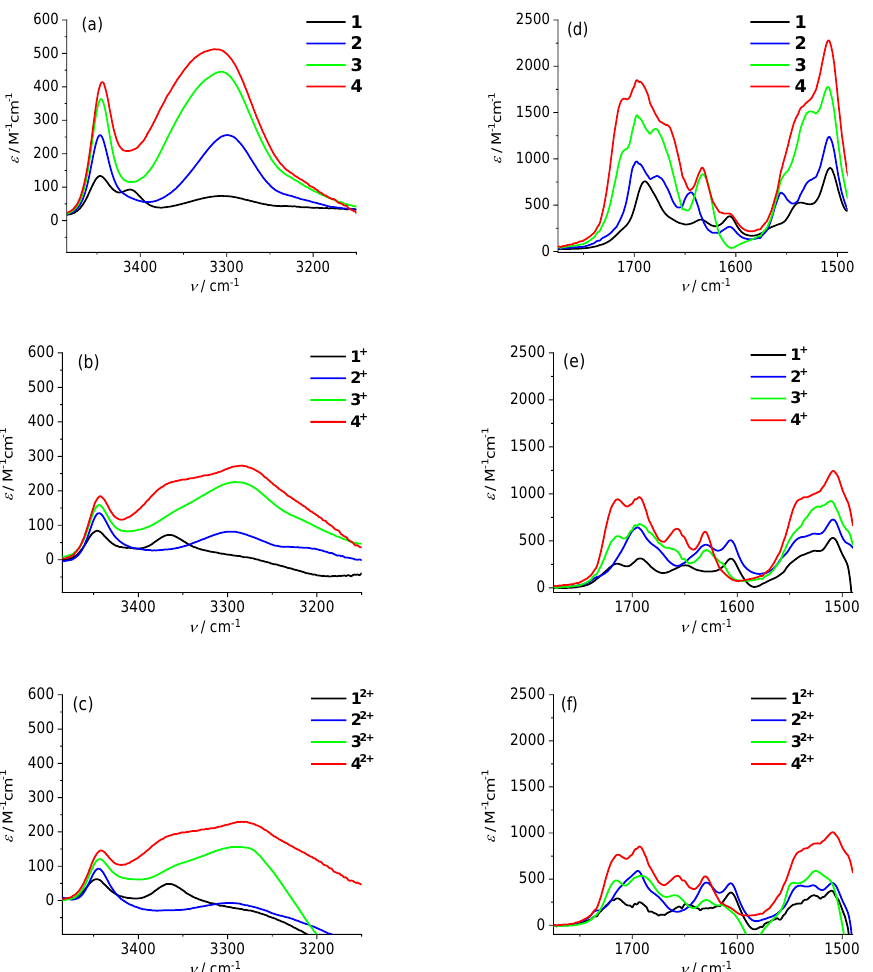
Figure 10. IR absorption spectra ( left : amide A region, right : carbonyl region) in CH 2 Cl 2 /0.1 M n Bu 4 NPF 6 of ( a , d ) 1 – 4 ; ( b , e ) 1 + – 4 + obtained by addition of 1 equivalent of ferrocenium[BF 4 ] to 1 – 4 ; ( c , f ) 1 2+ – 4 2+ obtained by addition of 1 further equivalent of acetylferrocenium[BF 4 ] to 1 + – 4 + ; c = 0.7–2.4 mM.